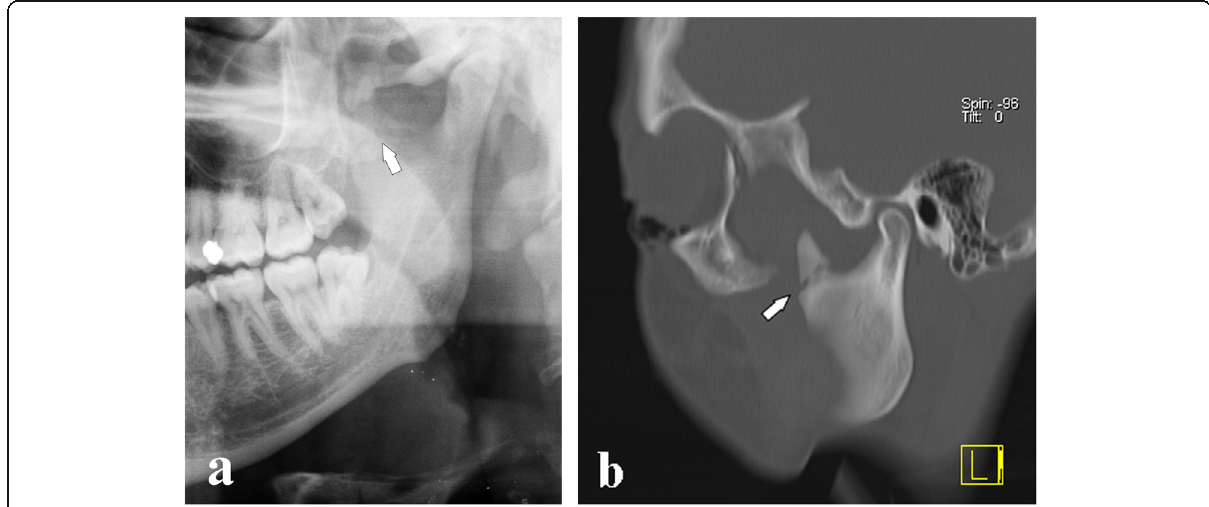
Fig. 9 Coronoid process apex fracture. a Cropped panoramic radiograph. The fracture rhyme (arrow) runs from the internal to external faces of the coronoid process. b Computed tomography 5-mm oblique reconstruction of the same patient. Note that the fracture rhyme (arrow) ends higher than the sigmoid